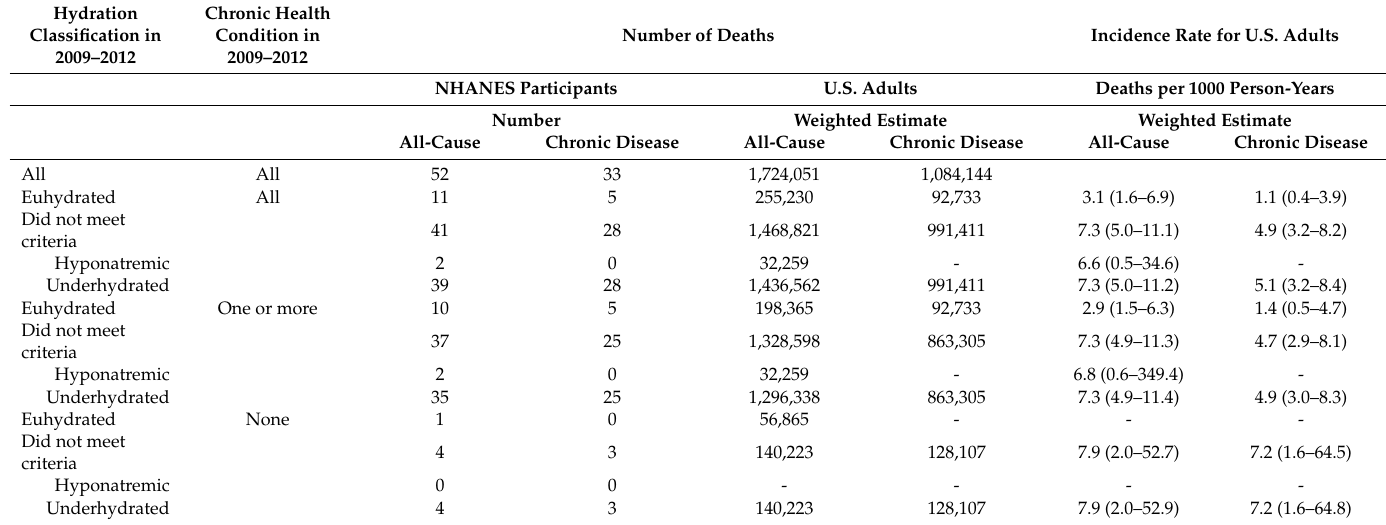
Table 4. Number of deaths in 3 to 6 years to U.S. adults aged 51–70 years by hydration classification and chronic health